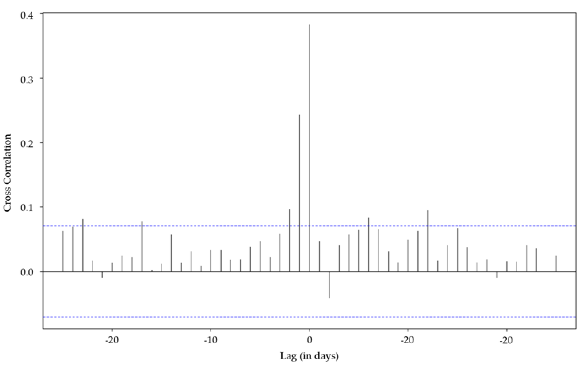
Figure 4. Cross-correlation function for pre-whitened and differenced time series of DMWT and LST for one site in the JDR showing the highest correlation at lag 0. Blue dotted line indicates significance threshold of p < 0.05.